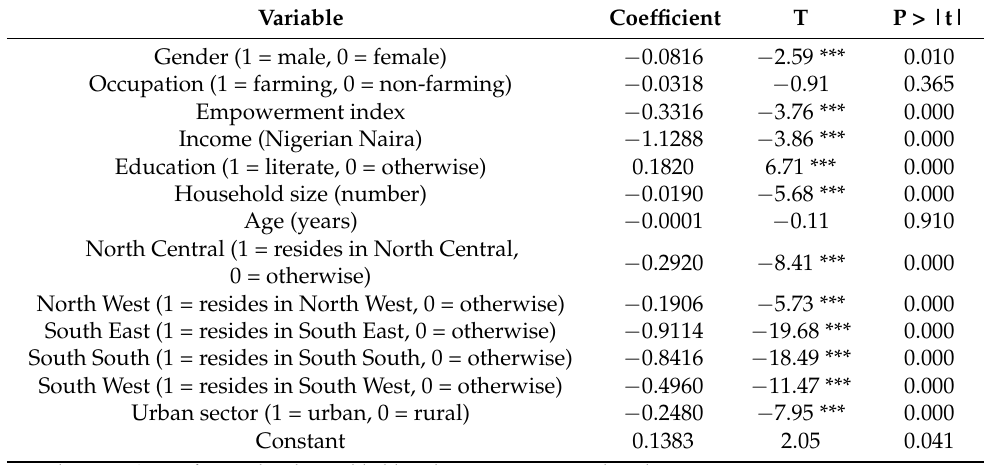
Table 10. Tobit regression model estimates of the determinants of food insecurity status of households in